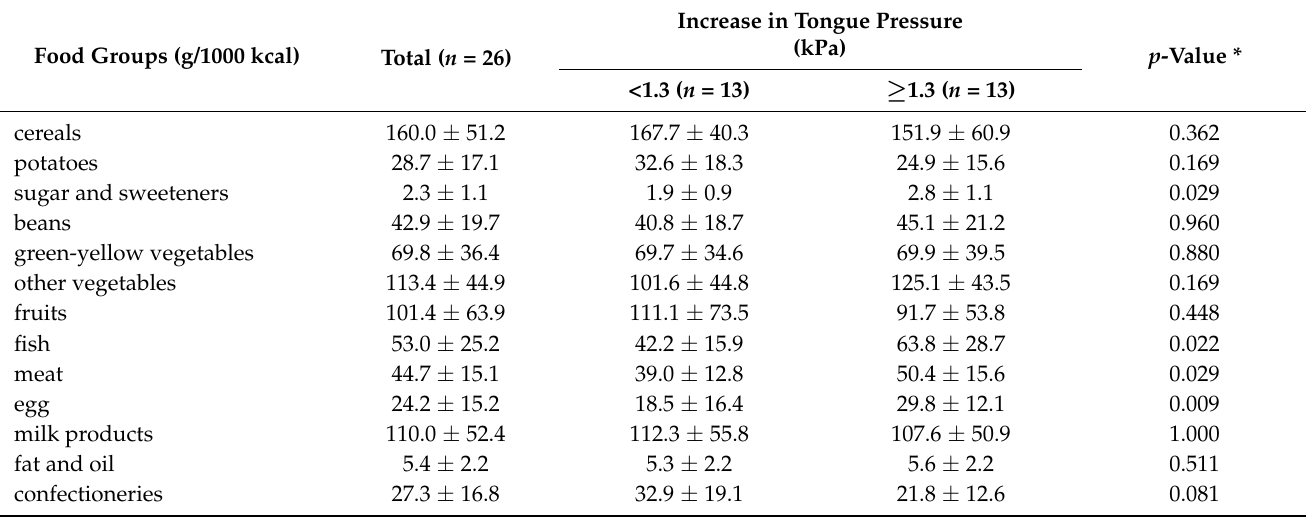
Table 5. Adjusted geometric means of daily food group at the baseline by the increase in tongue pressure at the